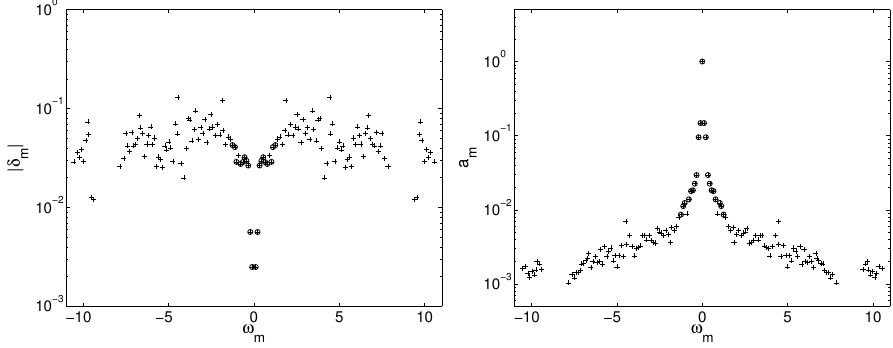
Figure 10. Counterpart of Figure 5 in the three-blades turbine applying HODMD in 196 snapshots starting at time 80.1